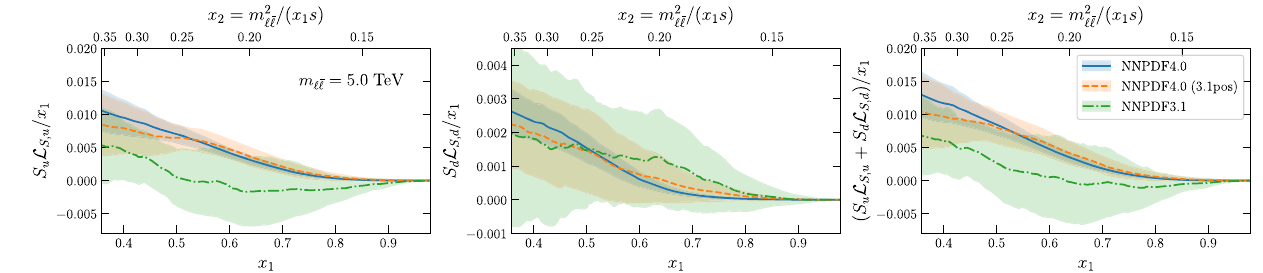
Fig. 22 Same as Fig. 12 (upper panels) comparing NNPDF4.0, NNPDF4.0(3.1pos), and